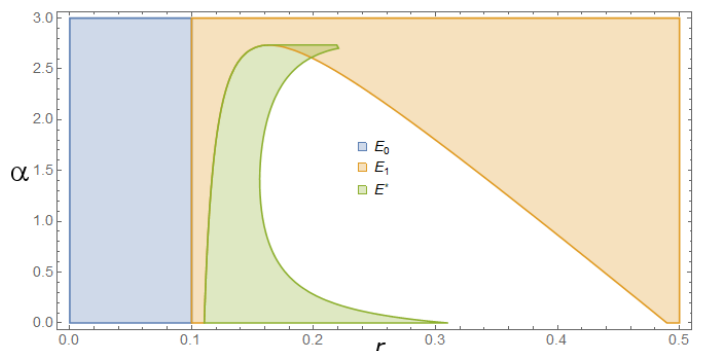
Figure 1. Stability regions for the equilibria E 0 (blue), E 1 (orange), E ∗ (green) of model (1) in the r − α plane; all the parameter values are chosen as in Table 1.